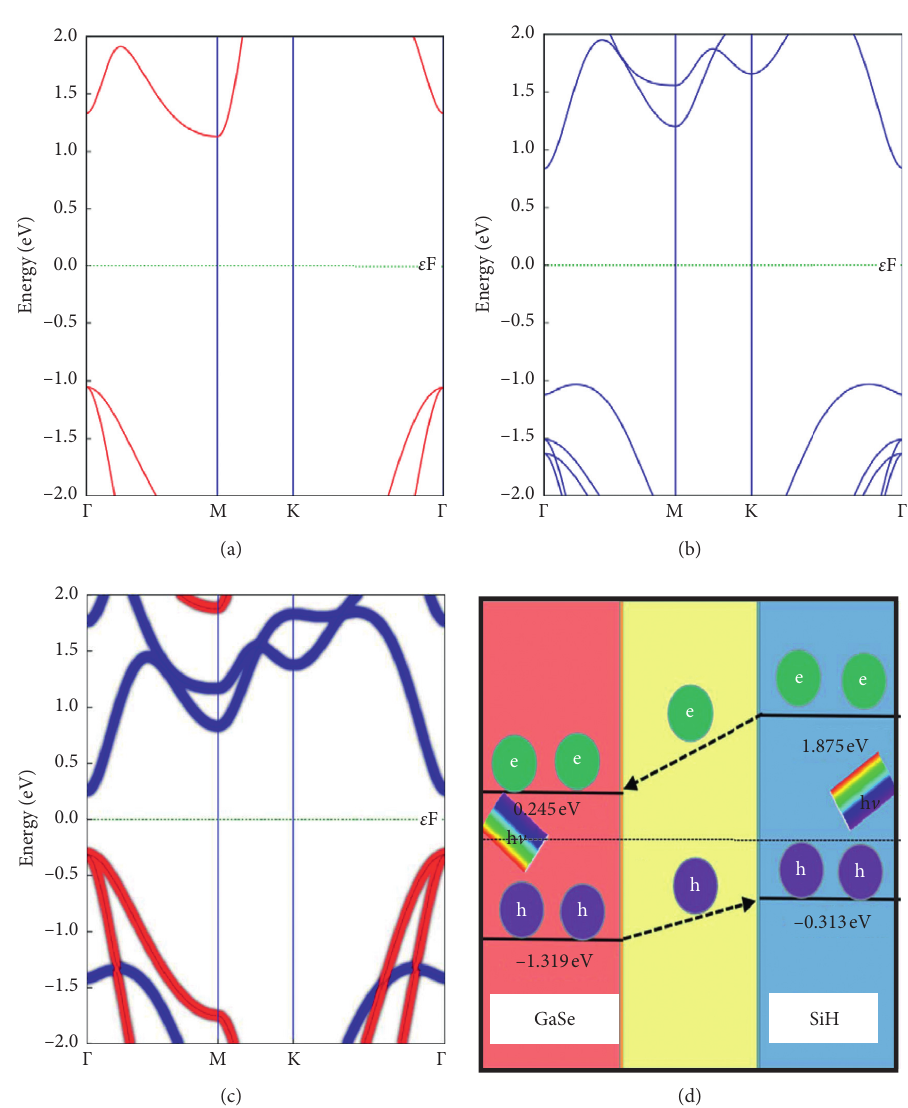
Figure 2: The band structures of (a) SiH, (b) GaSe, and (c) GaSe/SiH vdW heterostructure. The blue lines represent the GaSe, while the red lines represent the SiH. (d) The band offset of the GaSe/SiH vdW